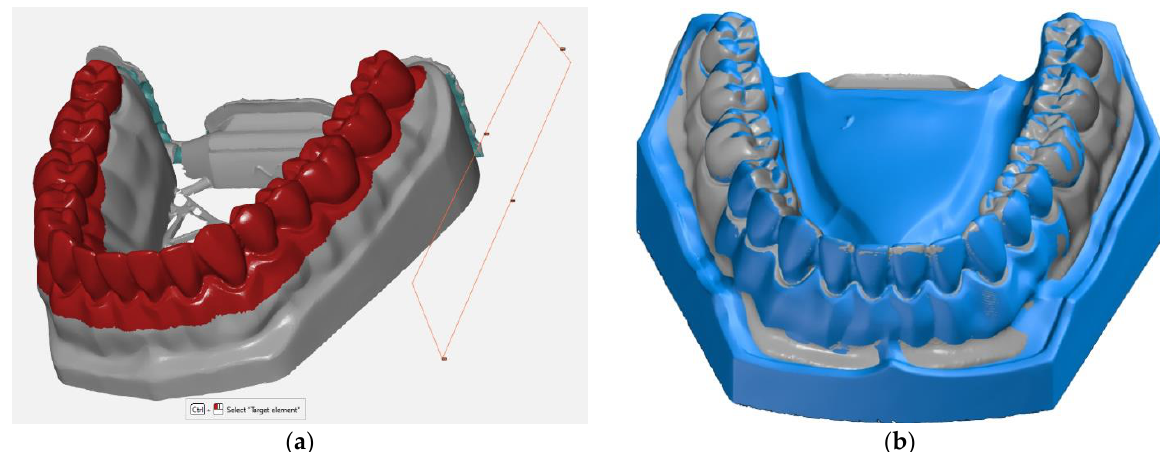
Figure 2. ( a ) Local best-fit alignment done in the region of interest between the 3D printed model and the reference surface; ( b ) the scanned surface (grey) and the reference surface (blue) overlapped.